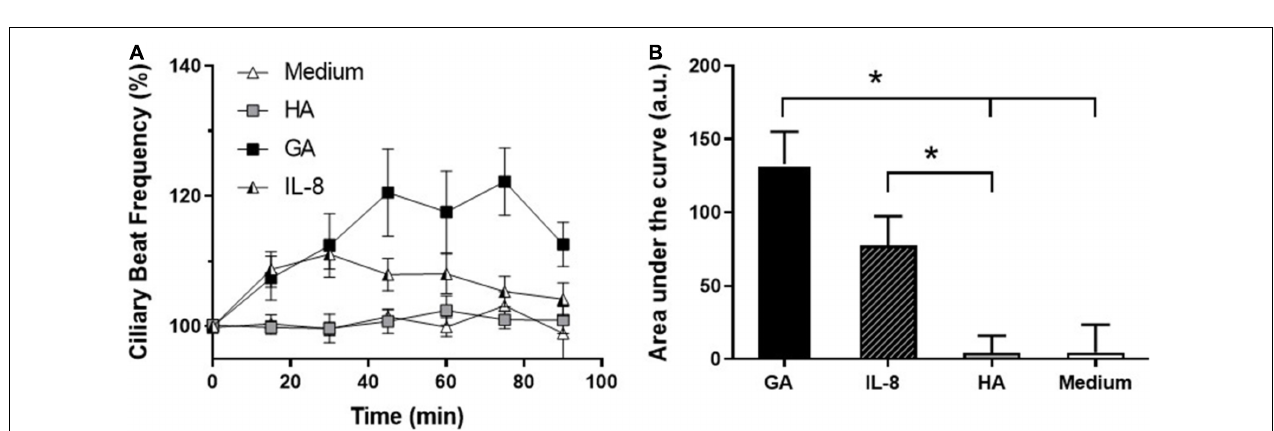
FIGURE 5 | Effect of glycated albumin (GA) and IL-8 in CBF. (A) Time-course changes in CBF of human adenoid epithelial ciliated cells cultures treated with GA ( (cid:4) , 2 mg/mL), IL-8 ( (cid:3) , 10 nM), albumin (HA, ◦ , 2 mg/mL), and culture medium ( (cid:52) ). GA and IL-8 induced an increase in CBF in the first 30 min of exposure, but only the increase of CBF induced by GA was sustained. (B) Time course of CBF in (A) expressed as area under the curve (AUC). GA induced a statistically significant increase in CBF with respect to HA and medium, and IL-8 with respect to HA. * p < 0.05. n = 4–5 cultures were used for each experimental point included in the time-course changes on CBF exposed to medium, HA, Il-8, and